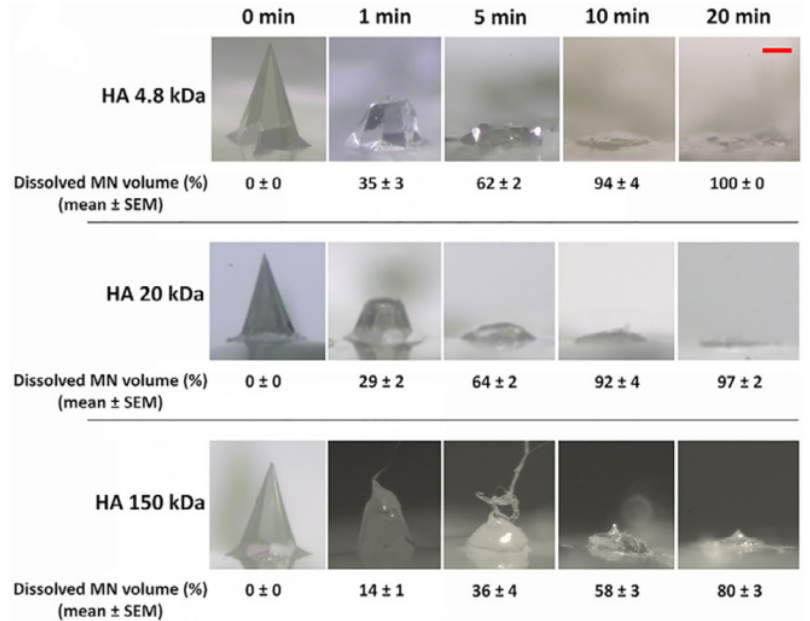
Figure 6. MNs dissolution in ex vivo human skin. Representative bright-field images (5) of 10% ( w / v ) HA 4.8 kDa, 20 kDa and 150 kDa microneedle before application on the skin (0 min) and after 1, 5, 10, and 20 min dissolution in ex vivo human skin. Scale bar 100 µ m [109]. Copyright 2020, with permission from Elsevier.